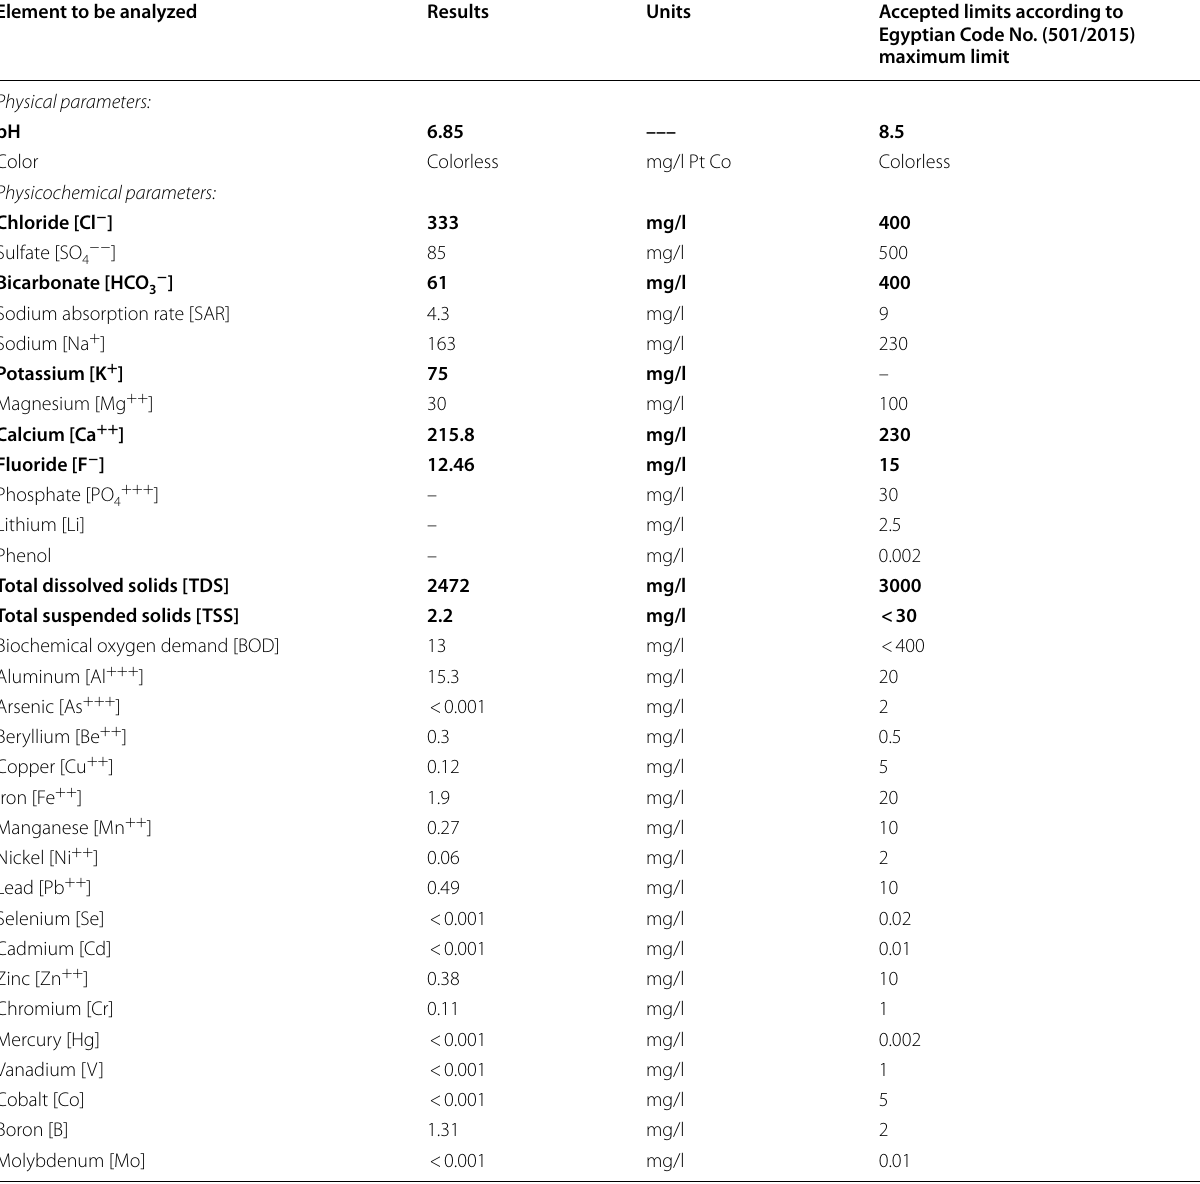
Bold are indicates the high levels of pollutants